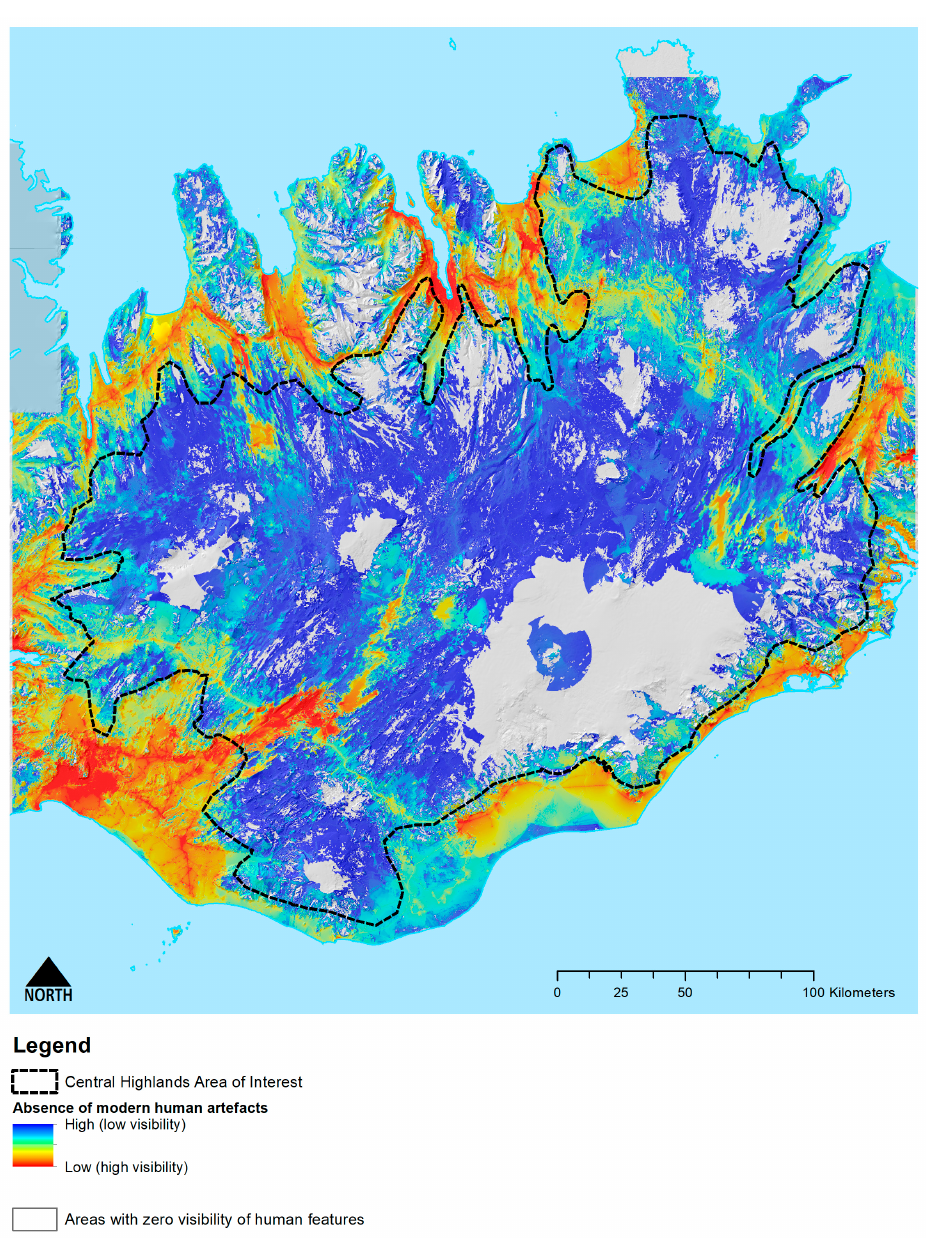
Figure 4. Absence of modern human artefacts .